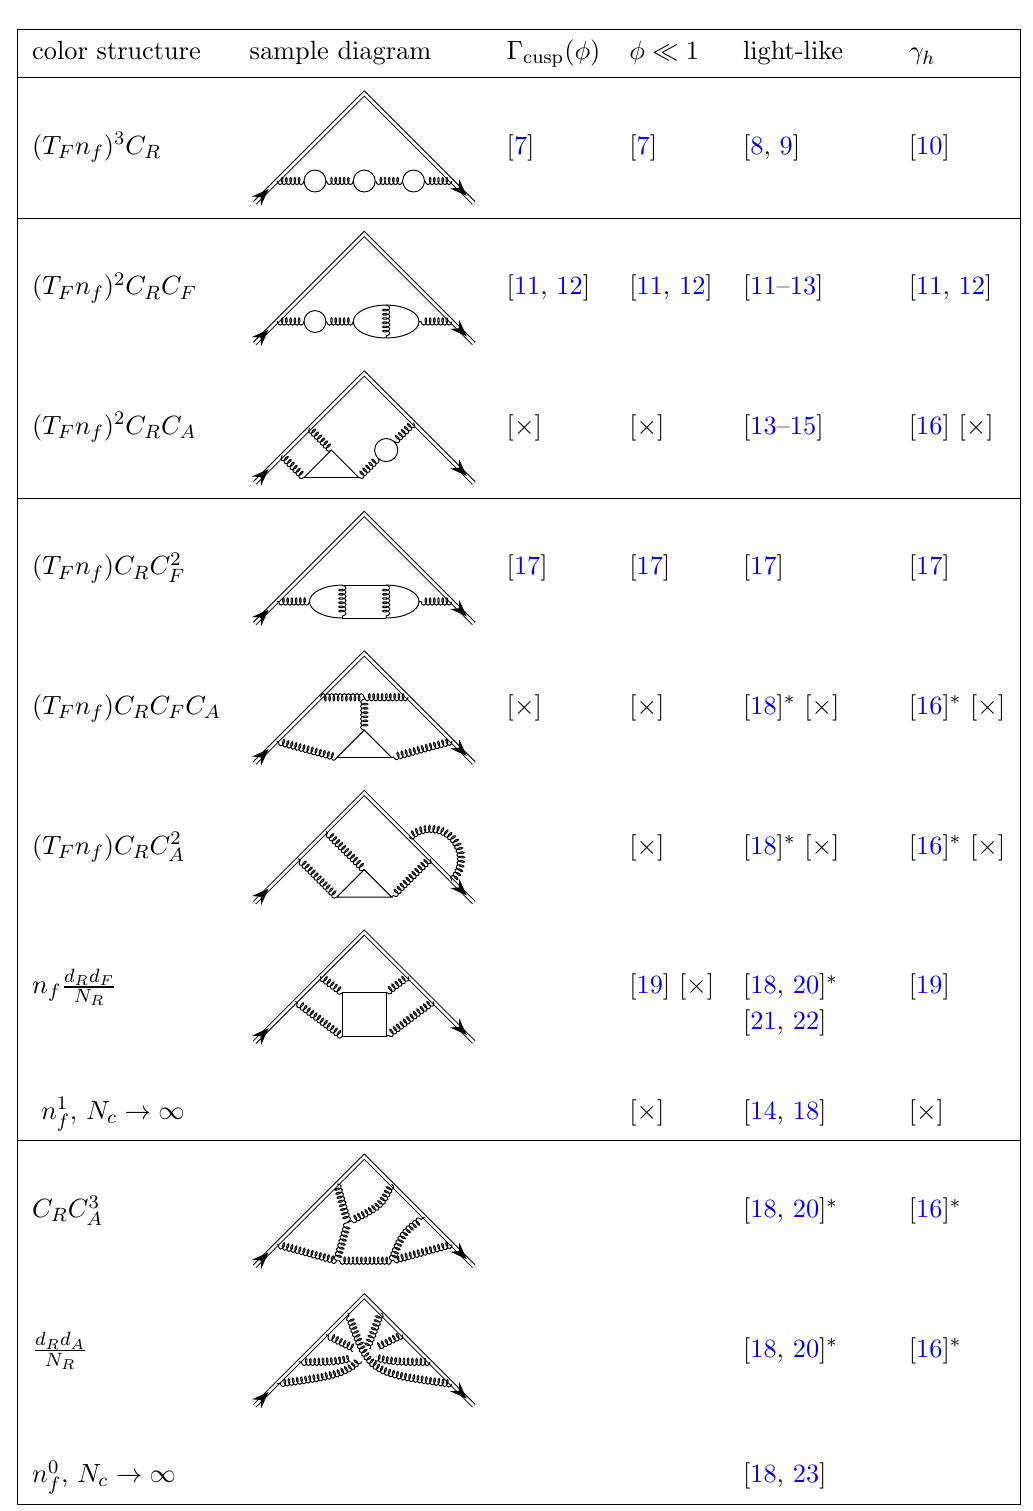
Table 1 . Four-loop contributions to (cid:0) cusp ( (cid:30) ) and its limits in QCD as well as the HQET (cid:12)eld anomalous dimension (cid:13) h . The (cid:3) marks numerical results. The results [ (cid:2) ] are obtained in the present paper.